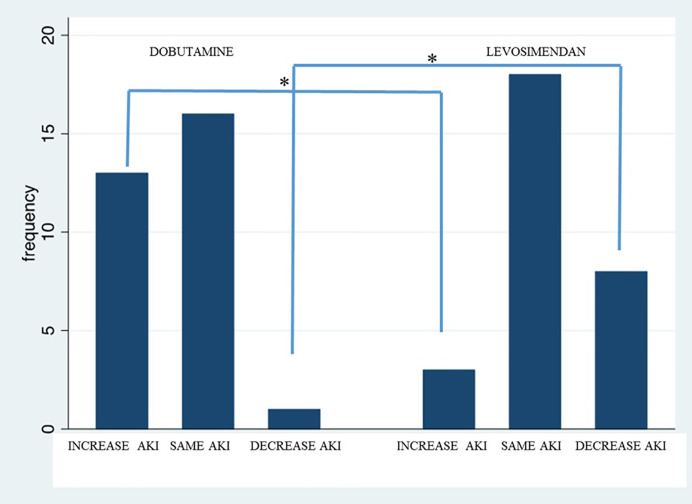
Variation of AKI stage after 48 h in patients treated with dobutamine vs. levosimendan. “*” statistically significant difference.